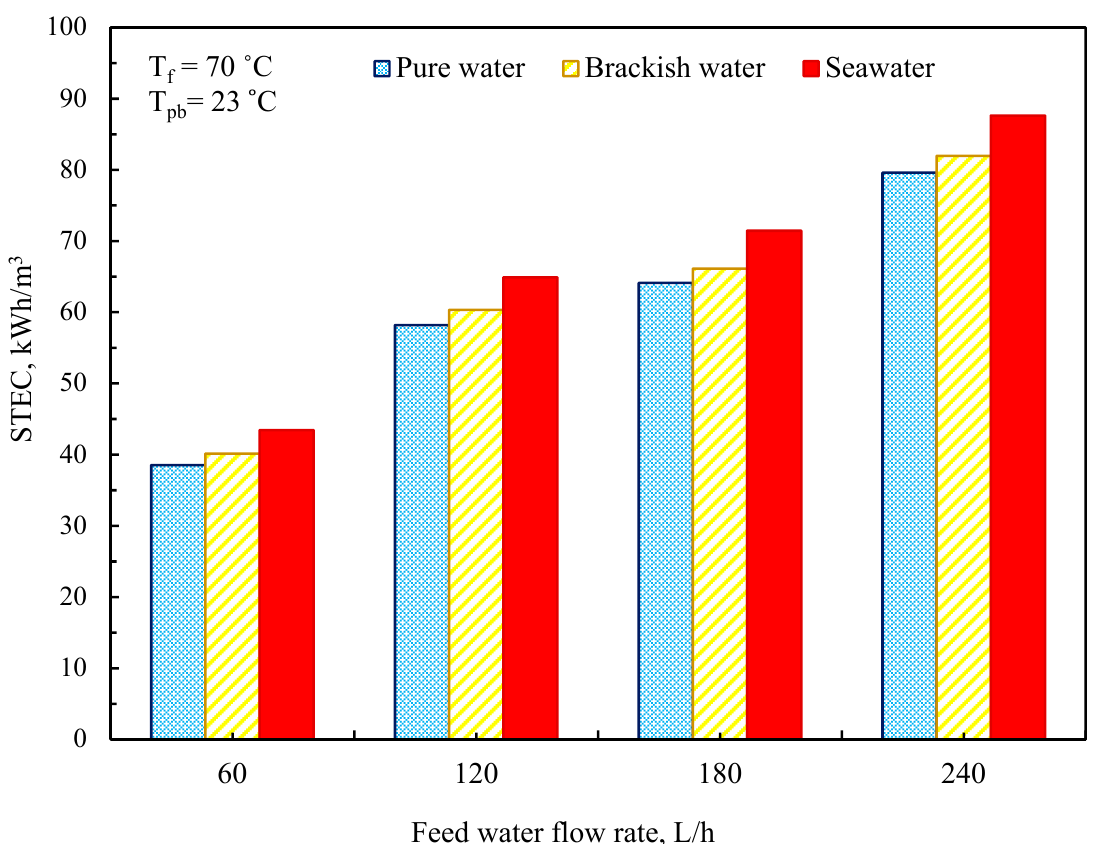
Figure 15. Specific heat energy consumption at a different feedwater flow rate.